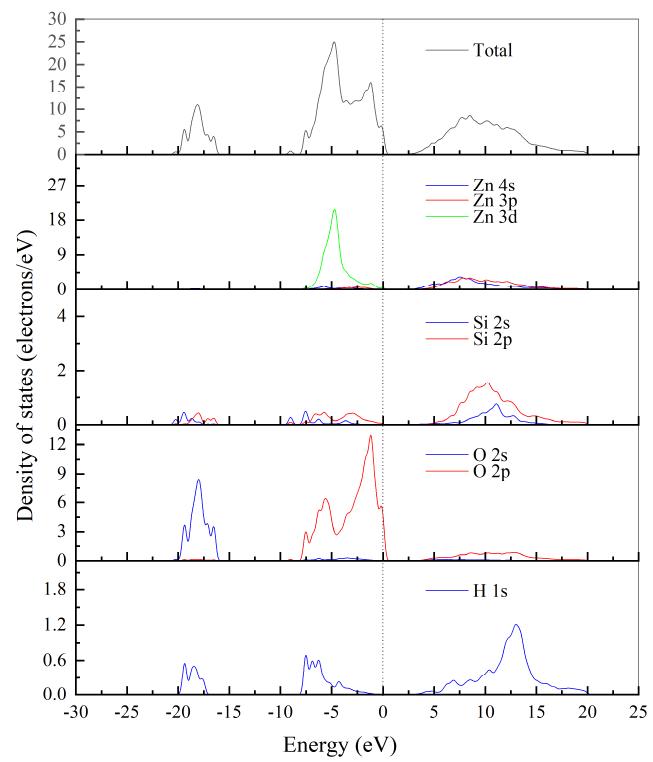
Figure 5. Calculated total and partial density of states of the atoms for the hemimorphite (110) surface.